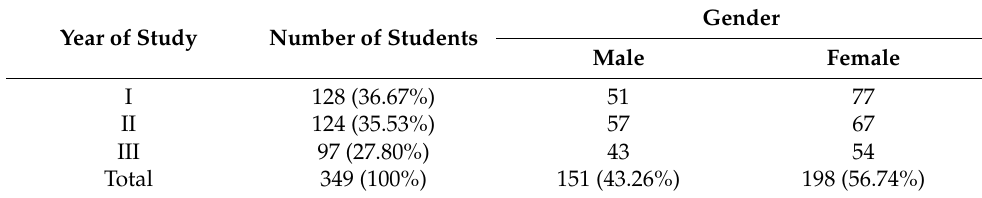
Table 1. Year of study, gender, and number of students within the Marketing specialization, under- graduate program.